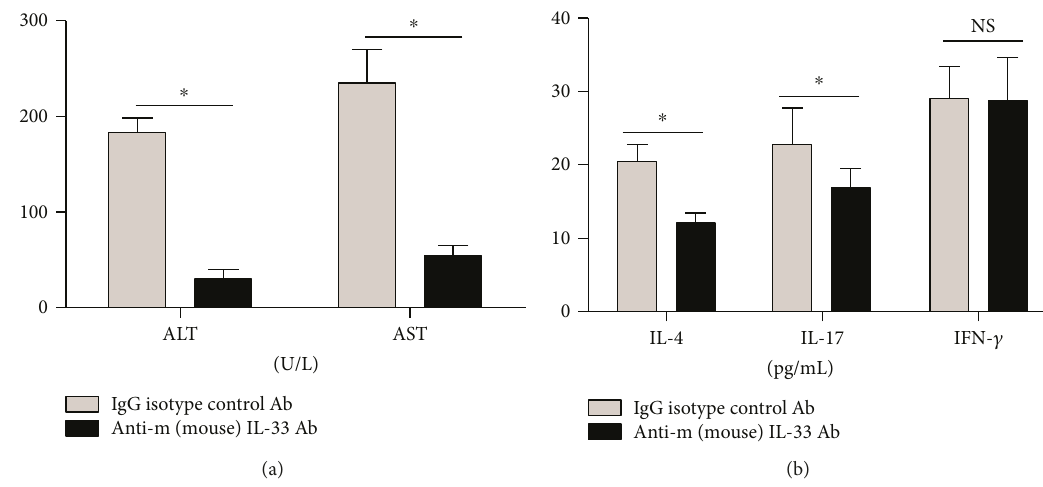
Figure 6: Levels of liver function and Th1/Th2/Th17-type cytokines after treatment with anti-m (mouse)IL-33 antibodies. Ten mice (5 EAIH mice treated with IgG antibodies and 5 EAIH mice treated with neutralizing IL-33 antibodies) were sacri fi ced on day 7. (a) Serum ALT/AST levels in EAIH mice with/without anti-mIL-33 antibody treatment; (b) serum levels of IFN- γ , IL-4, and IL-17 in EAIH mice with/without anti-mIL-33 antibody treatment. Data shown are the mean levels of each serum cytokine in each mouse from two separate experiments. The horizontal lines indicate the mean values for the di ff erent groups. ∗ P < 0 05